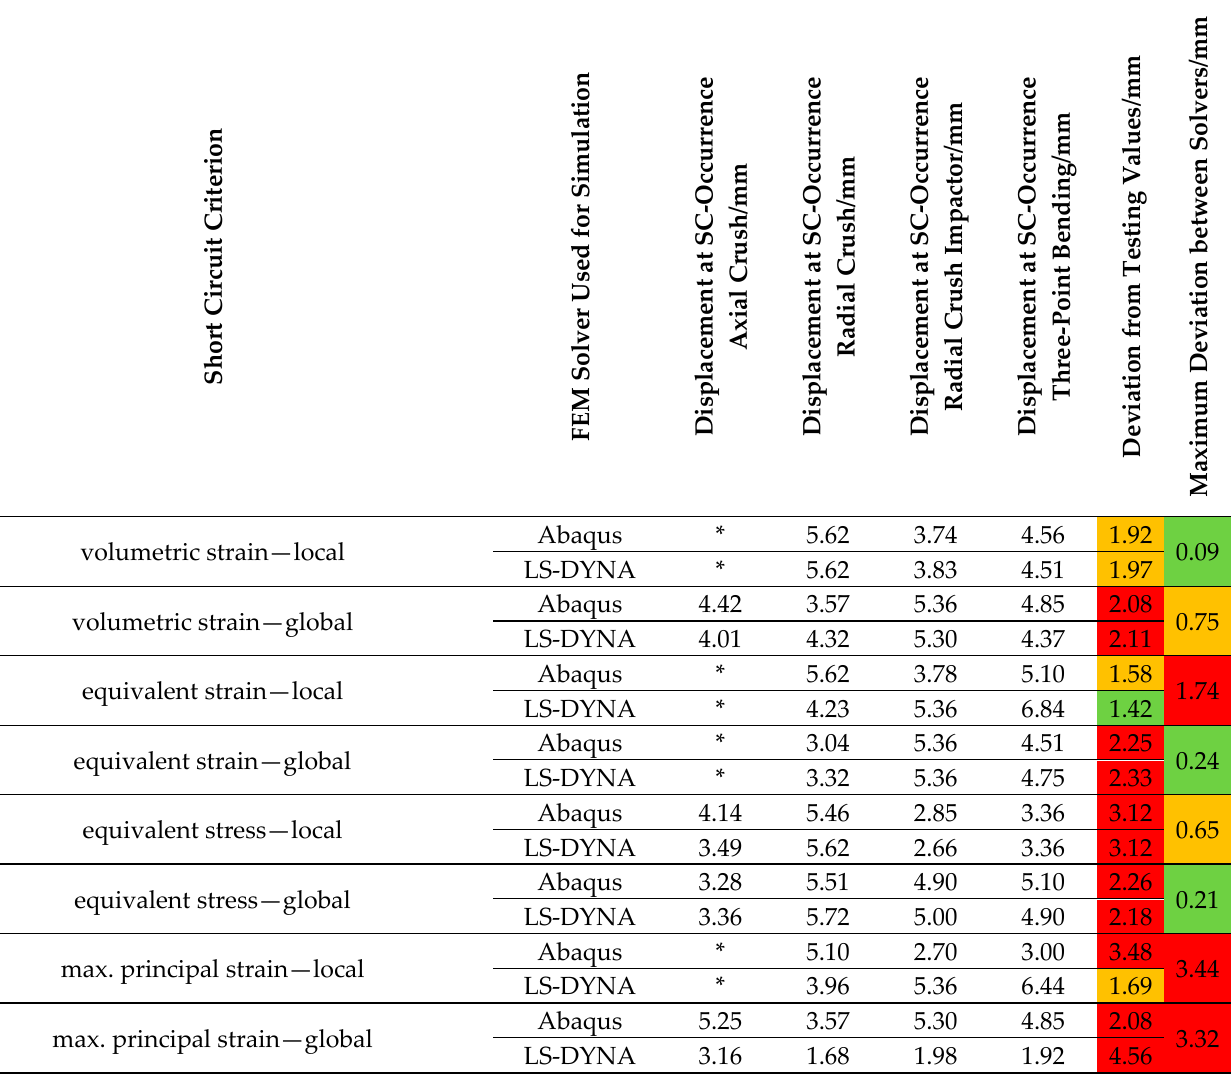
Table 4. Results for virtual short-circuit detection for four mechanical load cases using different criteria.